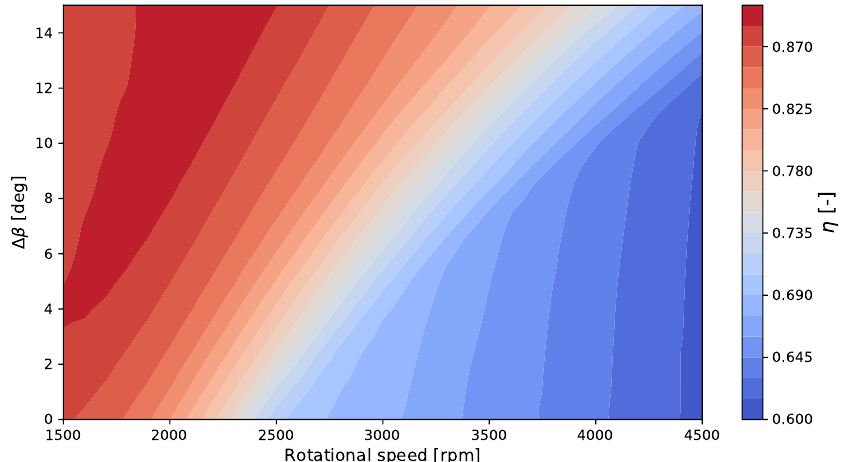
Figure 12. Sensitivity of the efficiency to changes in rpm and pitch angle of the blade in the off-design analysis procedure.